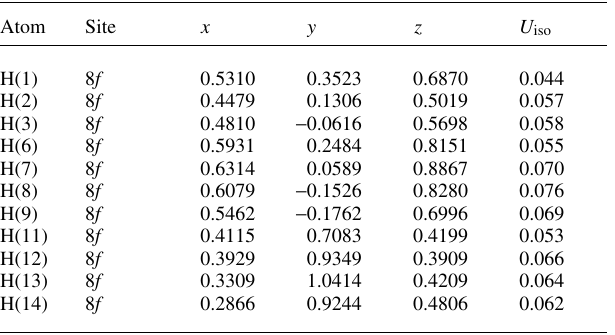
Table 2. Atomic coordinates and displacement parameters (in Å 2 )